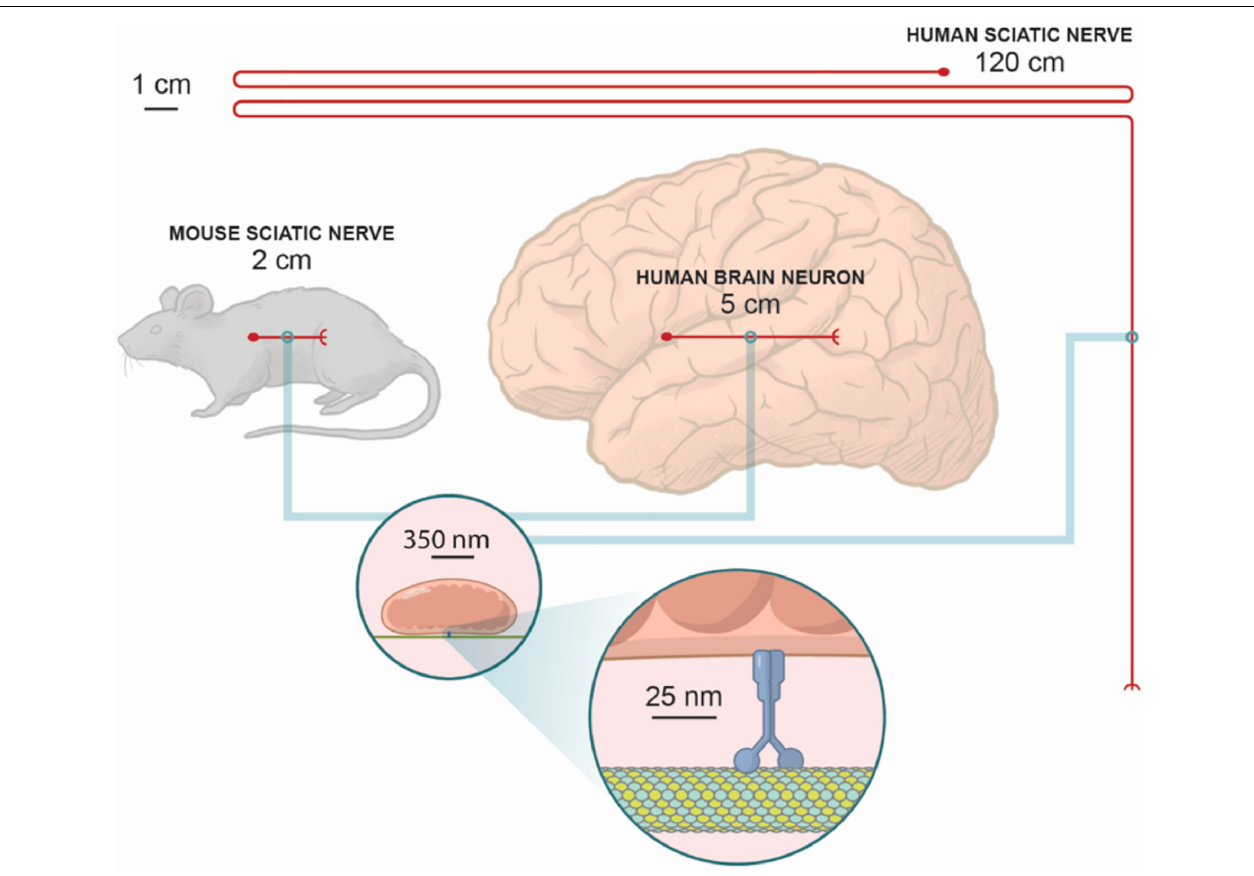
FIGURE 2 | The relative scales of axons in humans versus mice. While microtubules, motor proteins, and mitochondria have nearly identical sizes in mice and men, the length of the axons can be very different. At the same time, axons in the mouse sciatic nerve are not as long as some of the longer axons within the human brain. For example, it is known in the macaque there are direct connections from the frontal eye fields in the anterior bank of the arcuate sulcus to the primary visual cortex, which in the macaque is ∼ 5 cm, and probably as long as 12.5 cm in humans. Notably, for most CMT patients the pathology is often constrained to only peripheral neurons. Since the same mutations can cause CMT in mice and men, the distances mitochondria must travel can only provide a partial explanation for the physiopathology of these